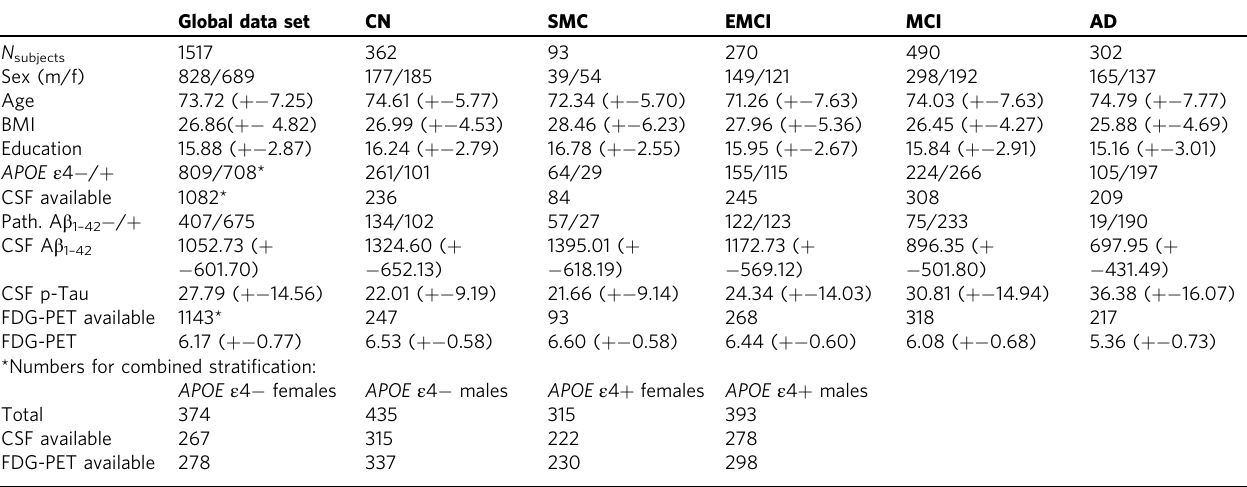
Table 1 Characteristics of the 1517 ADNI participants included in this